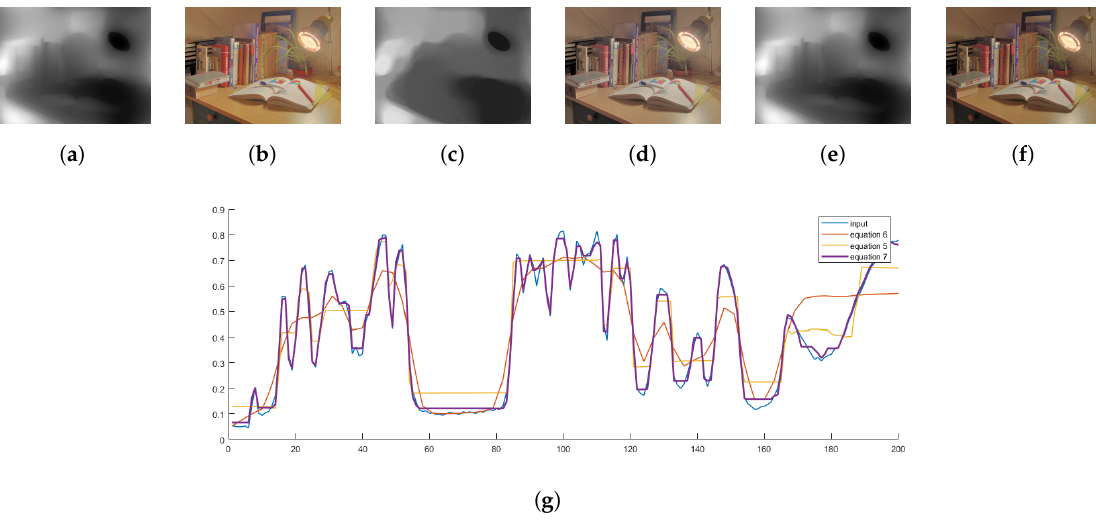
Figure 4. The above figure shows the effects of weight matrices and their respective outputs for the table lamp image. Image ( a ) is the resultant from the Equation (6) produced Image ( b ) with the brightest intensities and vibrant colors. This property contradicts the naturalness of the input scenario. The fourth Image ( d ) is a little dimmer than the first and slightly hazy compared to our Image ( f ). For the shown images, the contrast resulting from the use of Equation (7) causes them to appear more natural. Image ( g ) shows the approximation performance of the weight matrices for a scan line from the input image. For Equation (5), the scan line is least similar to the input scan line, which makes it less aware of the input image’s spatial property. For Equation (7), the resultant scan line is more likely to the input scan line, and from Image ( f ), produced output has a more desirable contrast distribution than Image ( b ) and Image ( d ). ( a ) Equation (6), ( c ) Equation (5), ( e ) Equation